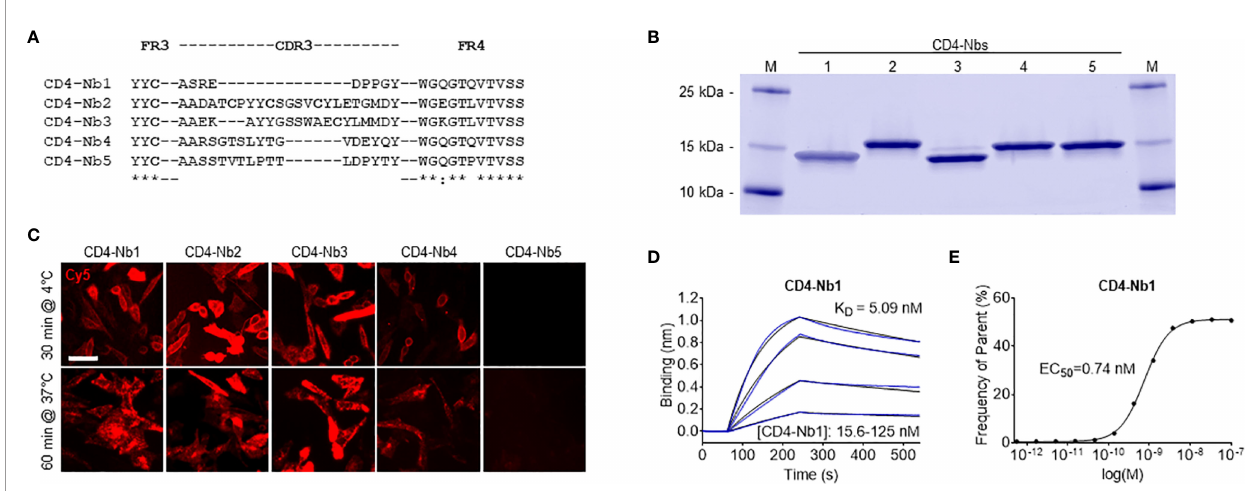
FIGURE 1 | Identi fi cation and characterization of nanobodies (Nbs) against human CD4 (hCD4). (A) Amino acid sequences of the complementarity determining region (CDR) 3 from unique CD4-Nbs selected after two rounds of biopanning are listed. (B) Recombinant expression and puri fi cation of CD4-Nbs using immobilized metal ion af fi nity chromatography (IMAC) and size exclusion chromatography (SEC). Coomassie-stained SDS-PAGE of 2 µg of puri fi ed Nbs is shown. (C) Representative images of live CHO-hCD4 cells stained with CD4-Nbs for 30 min at 4°C (top row) or 60 min at 37°C (bottom row); scale bar: 50 µm. (D) For biolayer interferometry (BLI)-based af fi nity measurements, biotinylated hCD4 was immobilized on streptavidin biosensors. Kinetic measurements were performed using four concentrations of puri fi ed Nbs ranging from 15.6 to 1,000 nM. As an example, the sensogram of CD4-Nb1 at indicated concentrations is shown. (E) EC 50 determination by fl ow cytometry. Exemplarily shown for CD4-Nb1, the percentage of positively stained HEK293-hCD4 (frequency of parent) was plotted against indicated concentrations of